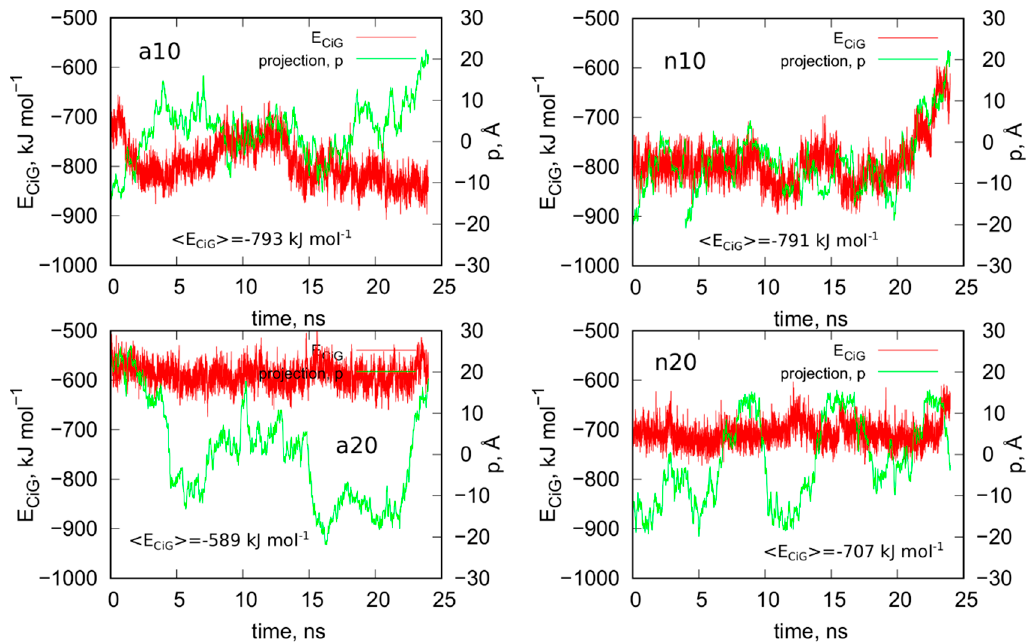
Figure 8. Interaction energy between iG and CNT for systems without guanine functional groups, E CiG as a function of time and projection of the center of mass of Gq and iM (taken together) into the CNT axis, p .